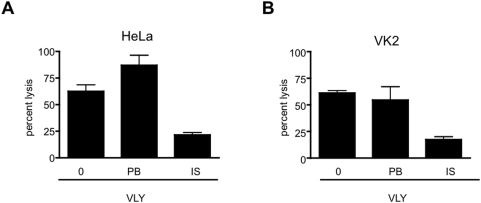
Immune serum inhibits VLY-mediated lysis of human cervical and vaginal cells.Human cervical (A, HeLa) or vaginal (B, VK2) epithelial cells were exposed to VLY (10 µg/ml), VLY+PB, or VLY+IS. Lysis was measured by LDH release assay following 30 min of incubation with toxin. Values were normalized to 100% lysis for each cell line (P<0.05 for VLY+IS versus VLY+PB for HeLa and VK2 cell lines).